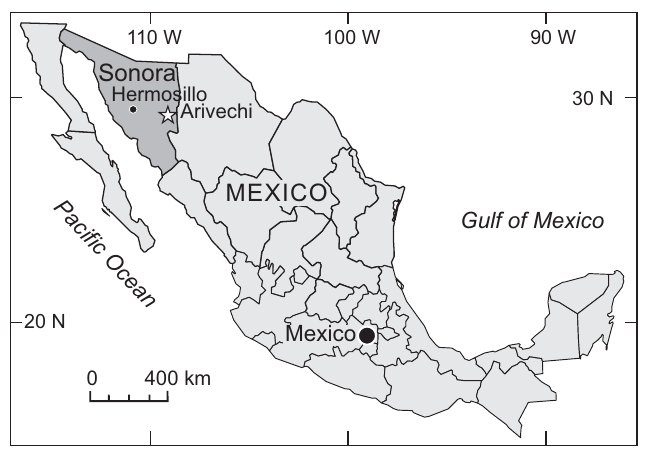
Fig. 1. Location map showing position of the Arivechi locality in central Sonora,